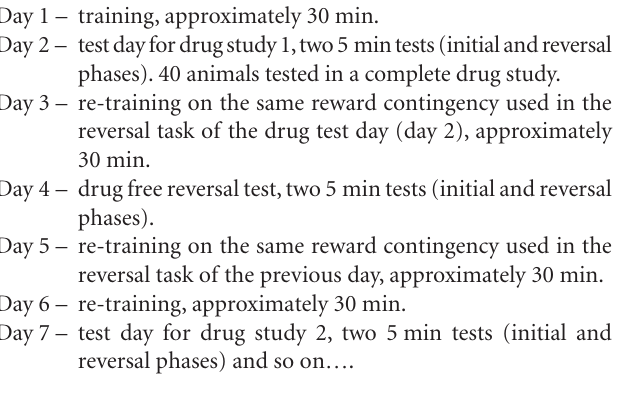
Table 1 | The order of drug experiments and an example of the drug treatments for one rat.